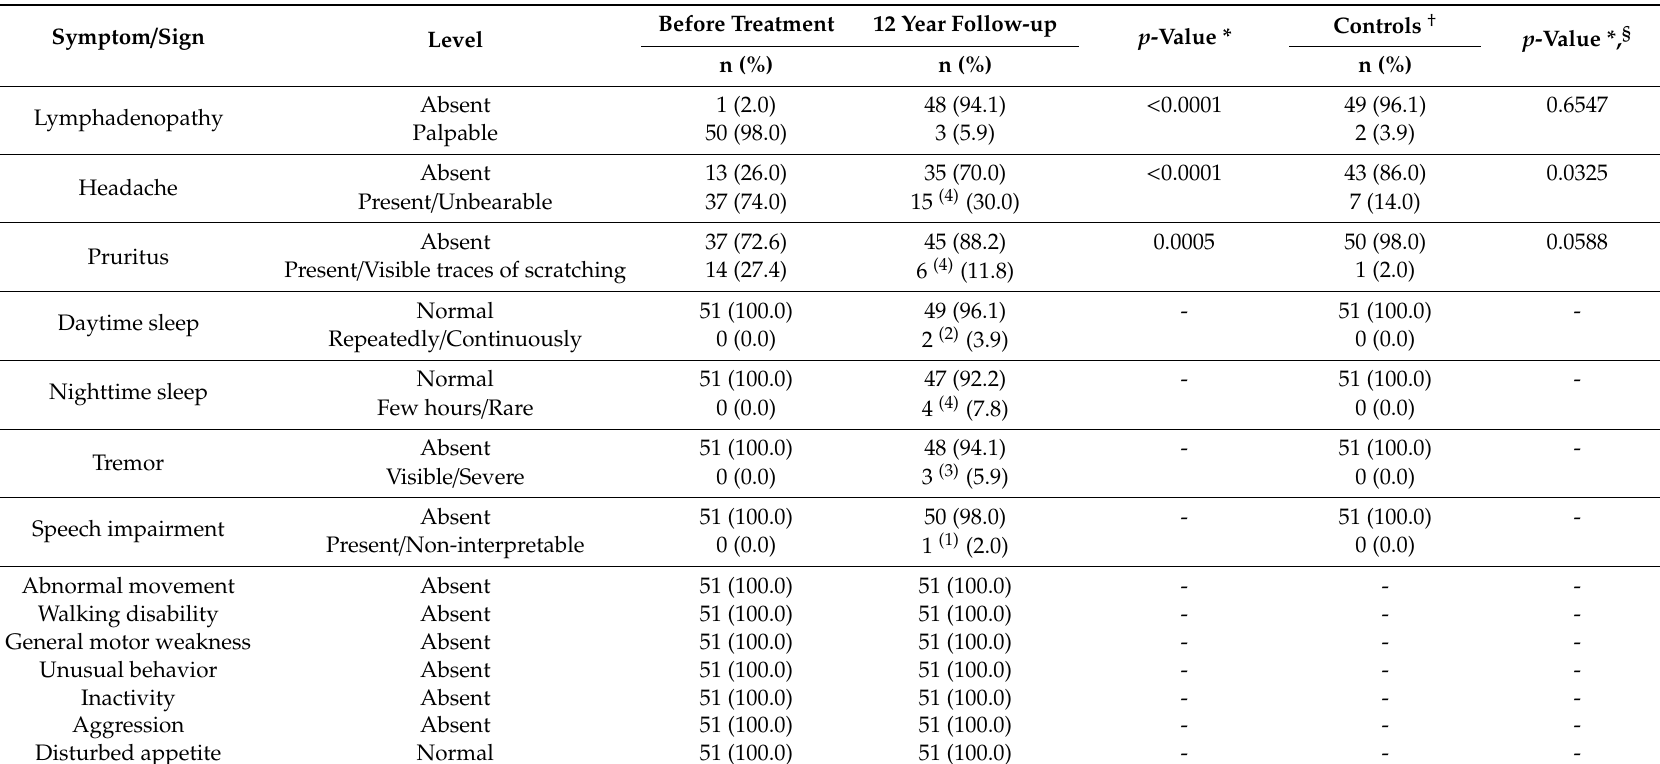
Table 2. First stage HAT: Signs and symptoms for patients before treatment and at 12 year follow-up and for their controls. Before Treatment Symptom / Sign Level